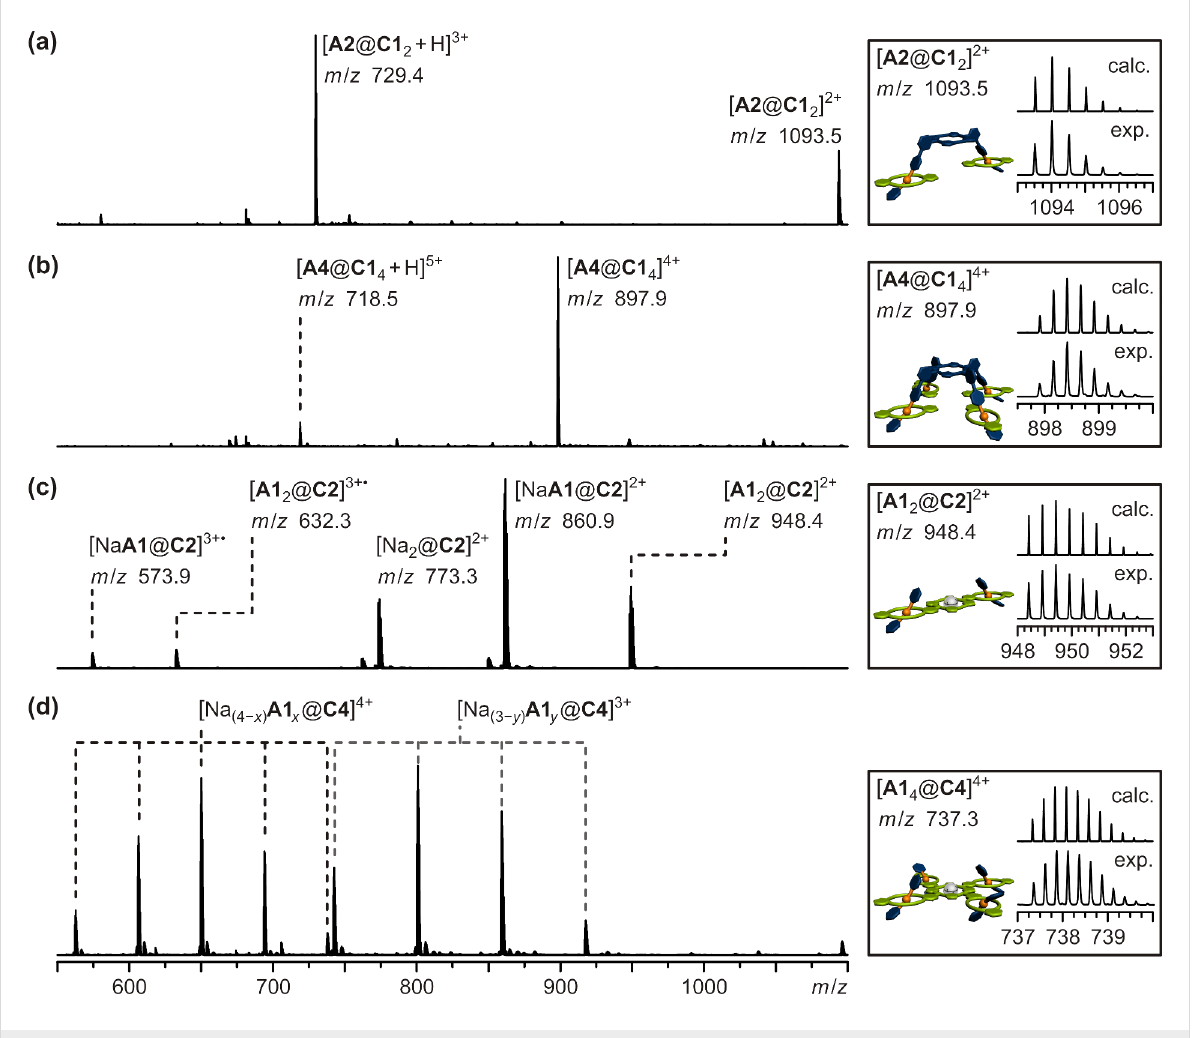
Figure 6: ESI-Q-TOF-MS spectra (CH 2 Cl 2 , 0.2 µM; left hand side) and respective experimental and calculated isotopic patterns of the desired [3]- or [5]pseudorotaxanes (right hand side): a) 1:2 mixture of A2 and C1 , b) 1:4 mixture of A4 and C1 , c) 2:1 mixture of A1 and C2 , d) 4:1 mixture of A1 and C4 . For reasons of clarity not all of the peaks are assigned (see Supporting Information File 1 for